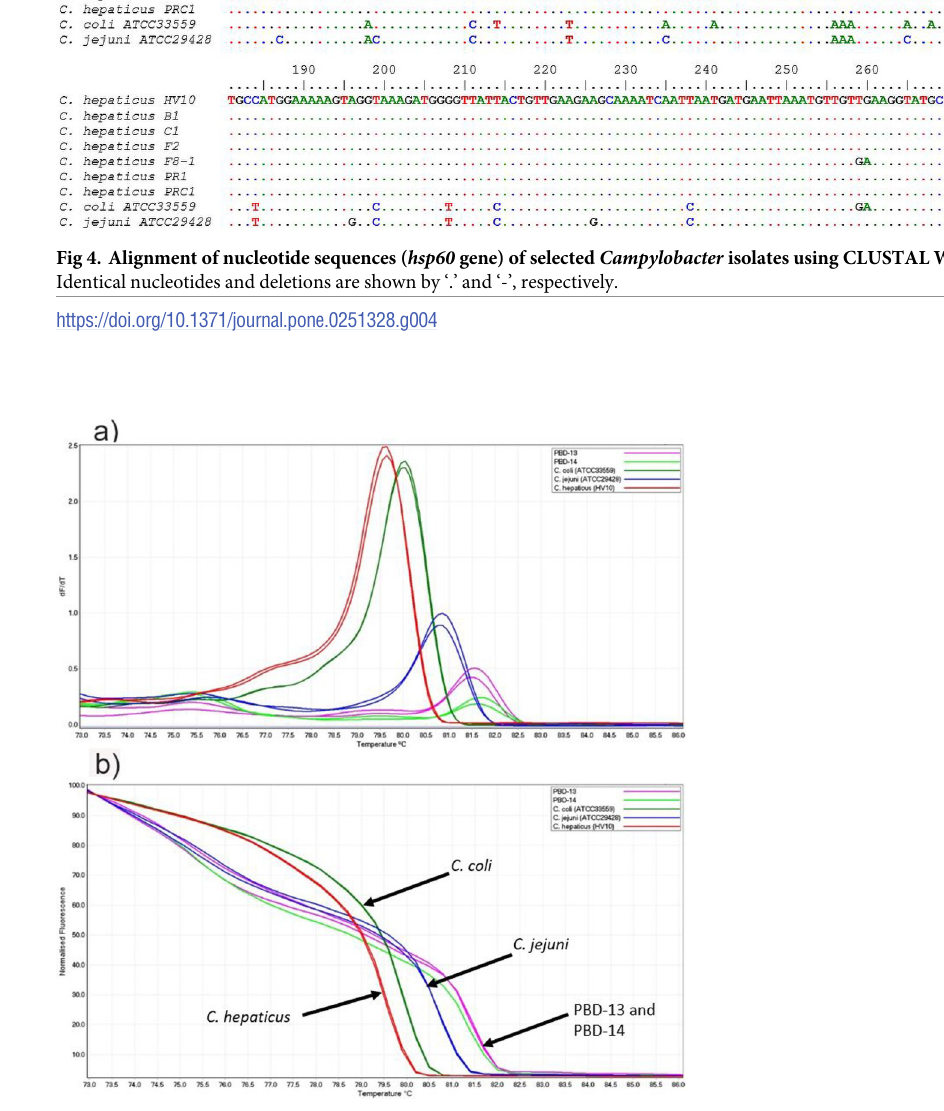
Fig 5. Conventional and normalised melt curve analysis of Campylobacter species. a) Conventional and b) normalised melt curve analysis of PCR amplicons from Campylobacter isolates detected in wild birds. All campylobacter spp. produced a single peak at different temperature. Campylobacter isolates from wild birds (PBD-13 and PBD-14) had melting points higher than C . coli , C . jejuni and C . hepaticus .